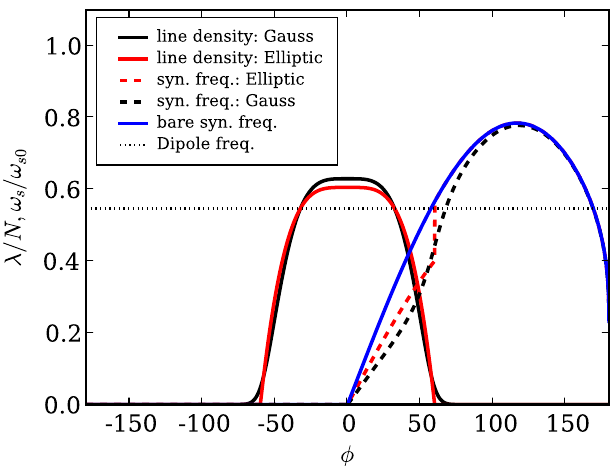
FIG. 3. (Color) Matched line densities for (cid:1) (cid:7) 1 and bunch (cid:7) 60 (cid:12) in the case of equivalent matched elliptic length (cid:1) m and Gaussian bunch distributions in a double rf wave. The dashed curves correspond to the respective synchrotron frequen- cies. The horizontal line represents the dipole